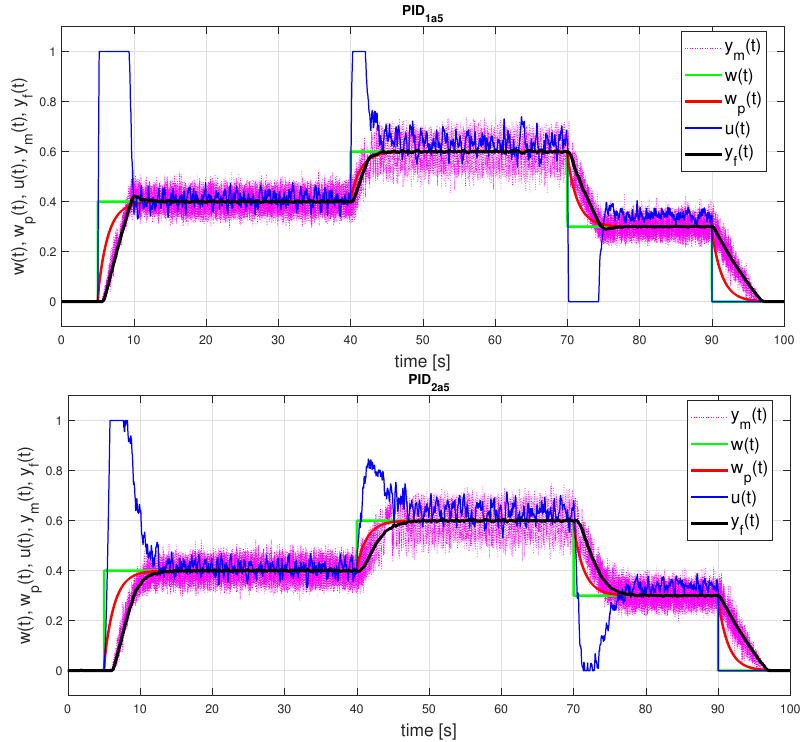
Figure 10. PID control: setpoint responses corresponding to FOTD approximations of a longer initial part of a normed step response y ( t ) for t a ≤ 5 with both possible sets of the controller parameters